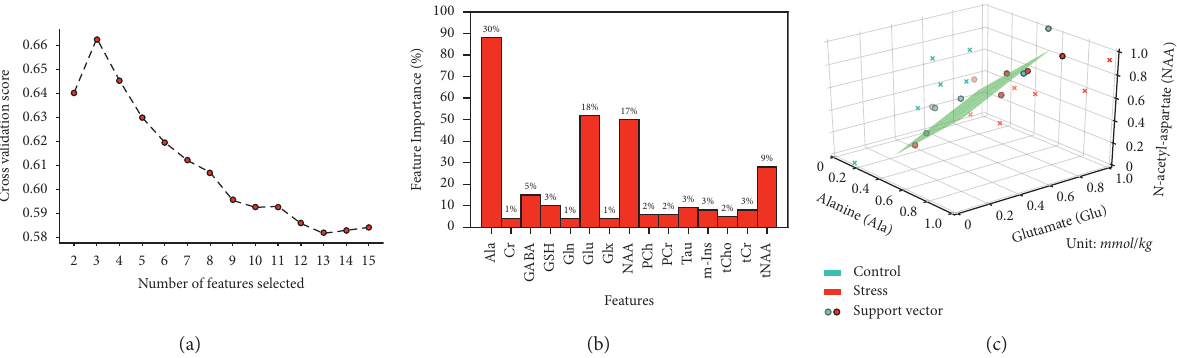
Figure 4: Feature importance and decision boundary using the SVM. (a) Optimal number of features that best classified both groups. (b) Feature importance to select the features that best discriminated between both groups. The importance of the feature represented how important the metabolites (i.e., features) were under the influence of acute restraint stress as a quantified quantity. (c) Three-dimensional decision boundary with Ala, Glu, and